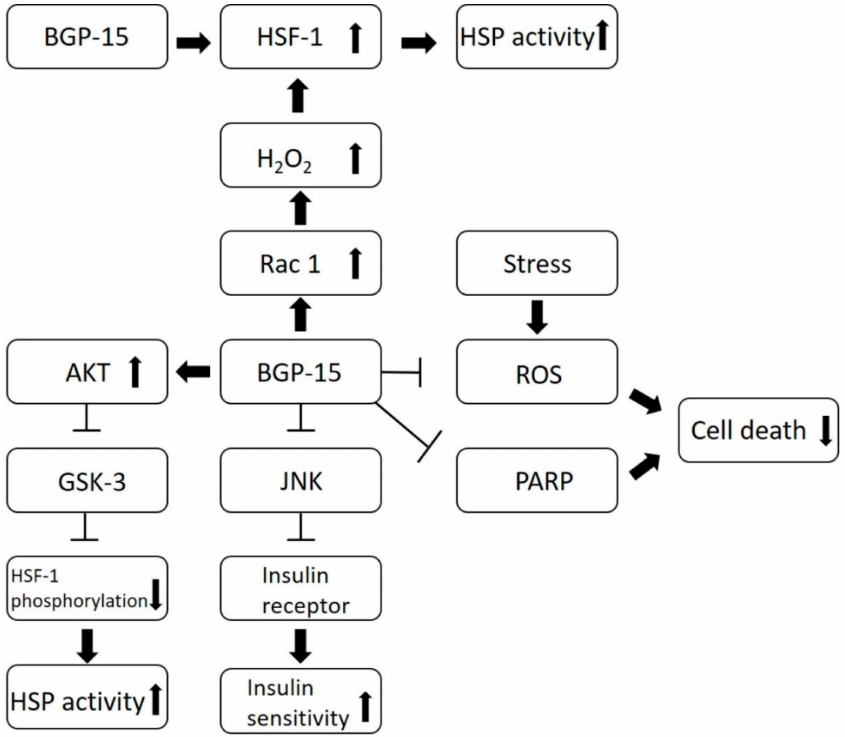
Figure 2. Mechanisms of e ff ects of